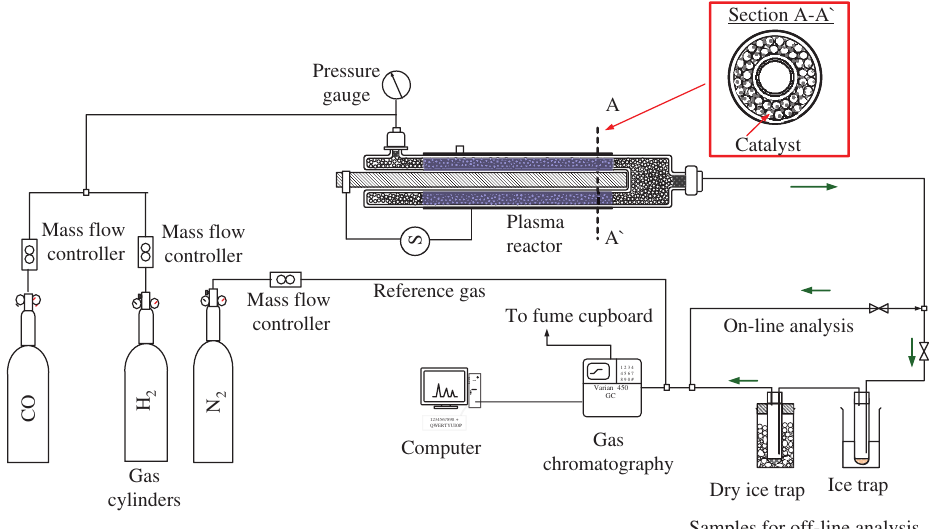
Figure 1 Schematic diagram of the set-up of the plasma promoted